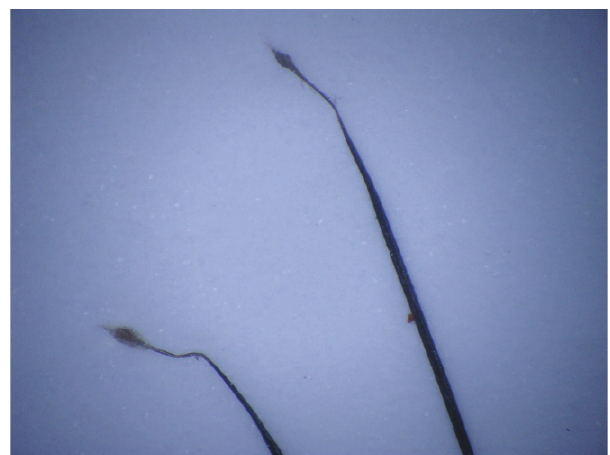
Figure 2 - Exclamation point